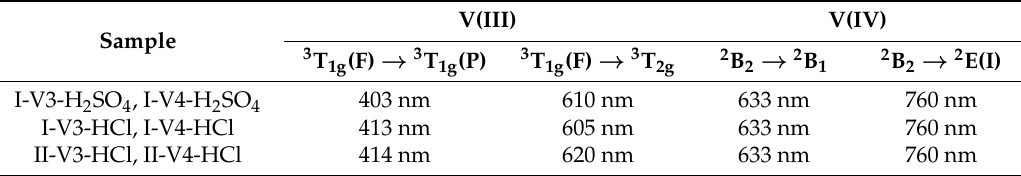
Table 2. Spectrophotometric data for vanadium(III) and vanadium(IV) species in various electrolyte matrixes.